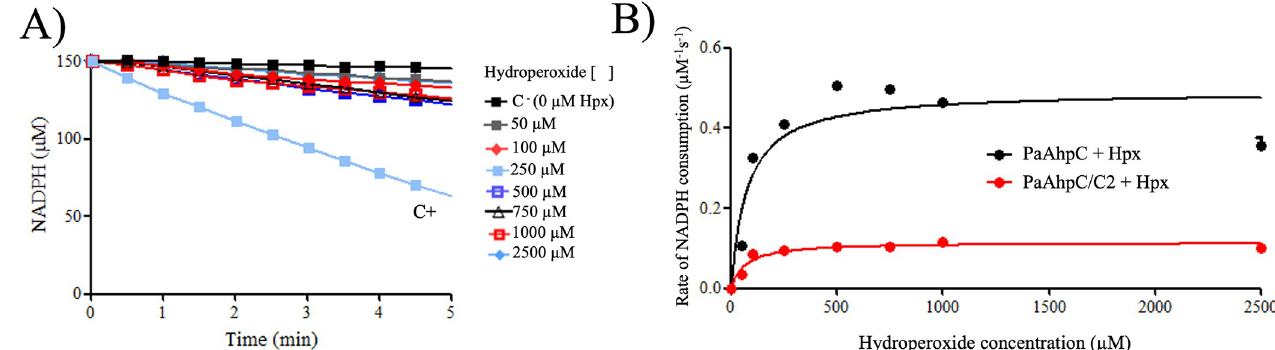
Fig 6. Inhibition characteristics of compound C2 over PaAhpC with growing concentrations of organic hydroperoxide. ( A ) NADPH oxidation assay of PaAhpC samples previously reduced with DTT and desalted, then treated with 20 μ M of compound C2 for one hour at RT previously treated. The reactions contained with 3 μ M of PaAhpC, 6 μ M of EcTrx, 0.9 μ M of EcTrxR, 150 μ M of NADPH, 50 mM of HEPES (pH = 7.4), 100 μ M of DTPA and 1 mM sodium azide were used. Prior to experiments the reactions were incubated at 37˚C/5 min and reactions were started by the addition of growing concentration of cumene hydroperoxide—CHP (50–750 μ M) and monitored spectrophotometrically at 340 nm, 37˚C, for 5 minutes. As negative control was used reactions without the enzyme (black square) and as positive control were used PaAhpC samples without prior treatment with compound C2 (malibu square). The experiments were performed three times using triplicates. ( B ) Plot of the rates of NADPH oxidation by samples of pretreated with compound C2 (PaAhpC/ C2 ; red dots and line) or without inhibitor treatment (PaAhpC/ C2 ; black dots and line).